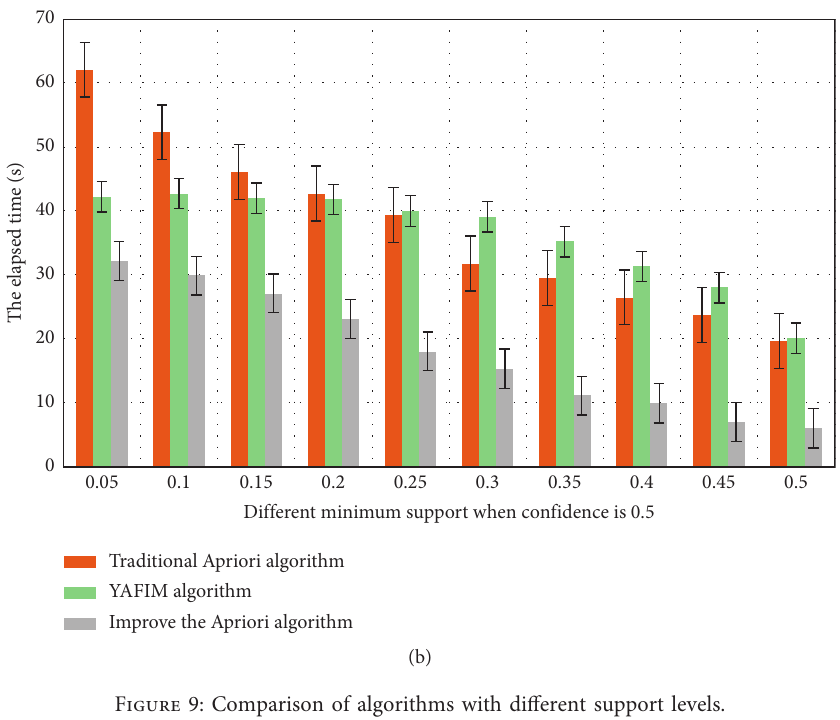
Figure 9: Comparison of algorithms with different support levels.